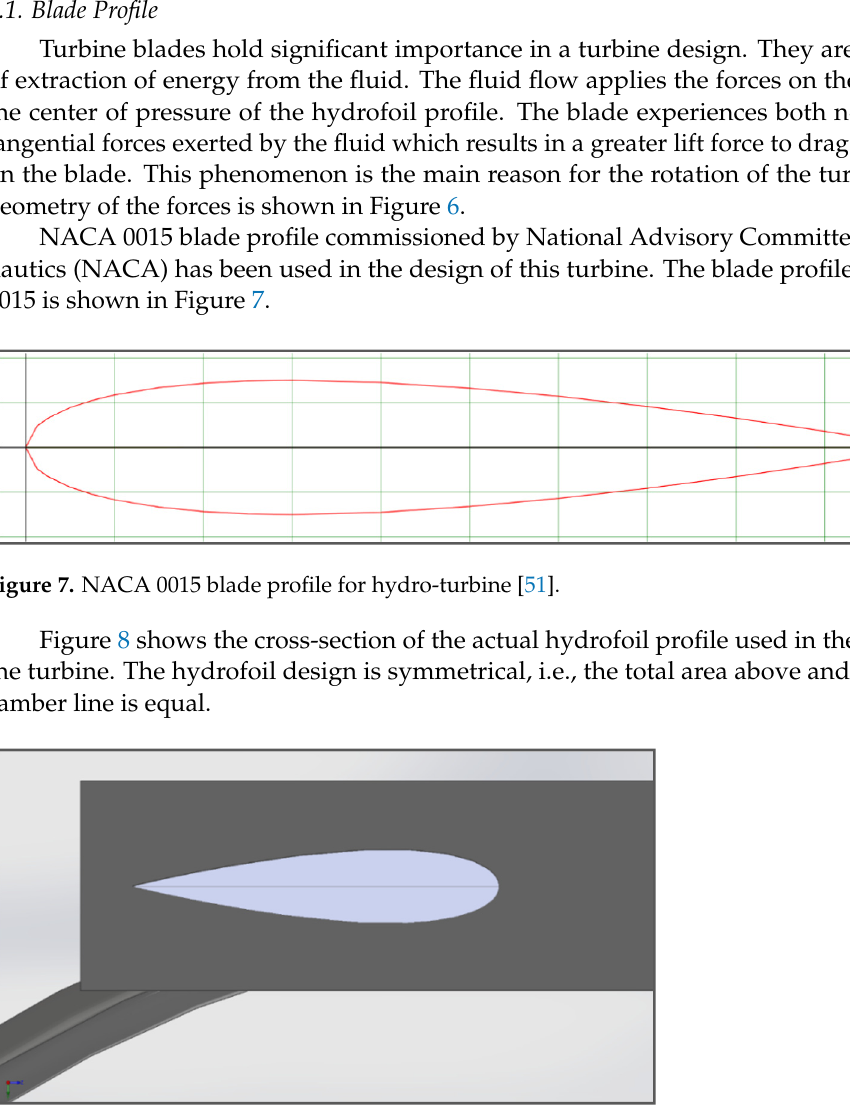
Figure 8. Blade profile of turbine based on the NACA 0015 design.